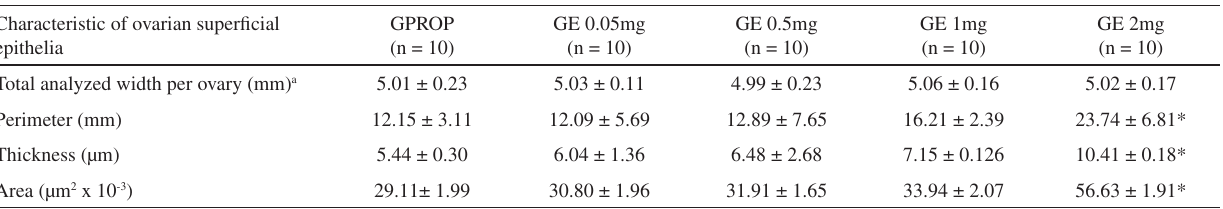
n = number of animals; a Sum of all clock position fields; *P < 0.01 compared to all other